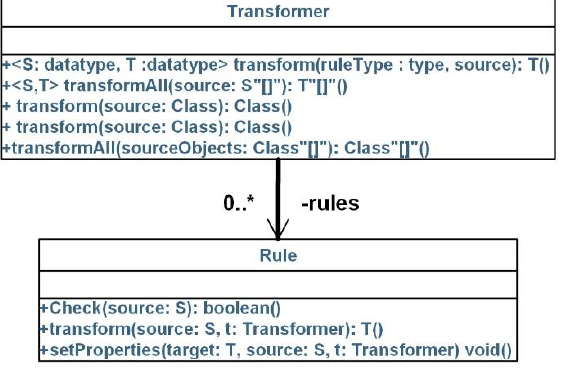
Fig. 4. Overview of